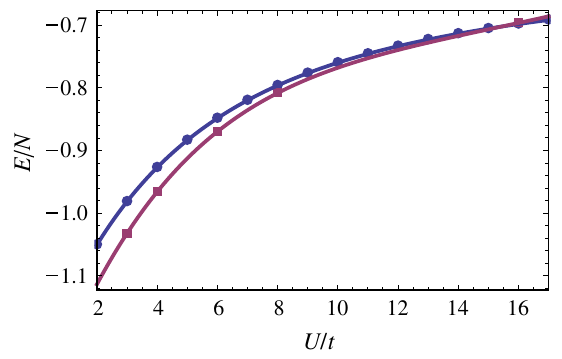
FIG. 7. Ground-state energy per site of the Hubbard model. Red line, 32-site sample, obtained by DMRG. Blue line, 8-site sample, obtained by ED. For 8-site sample, ED shows a twofold degenerate ground state.